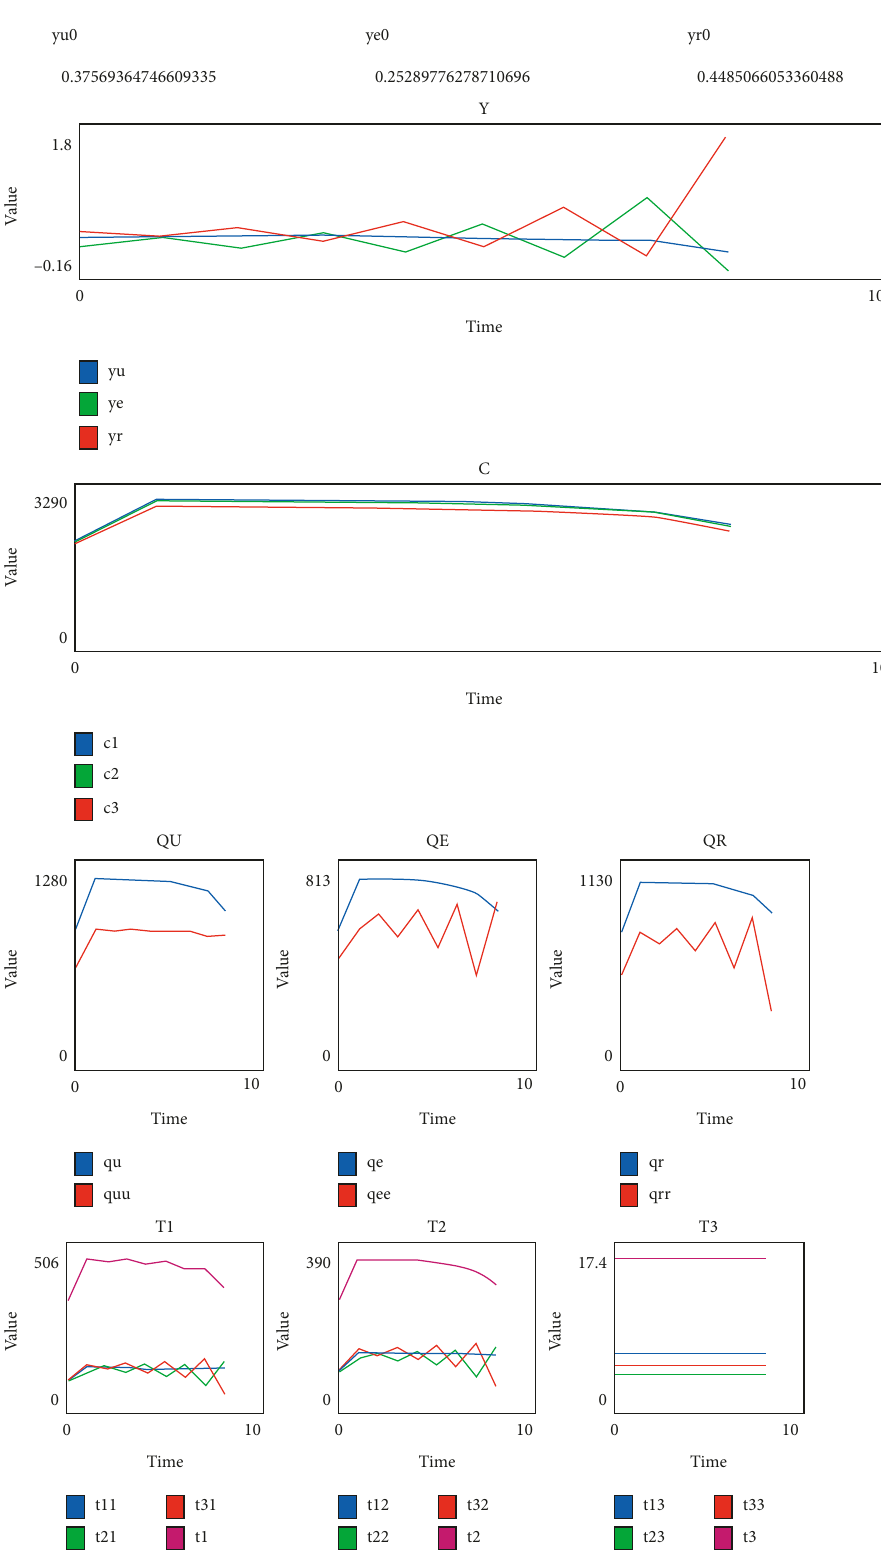
Figure 8: Simulation results of scenario